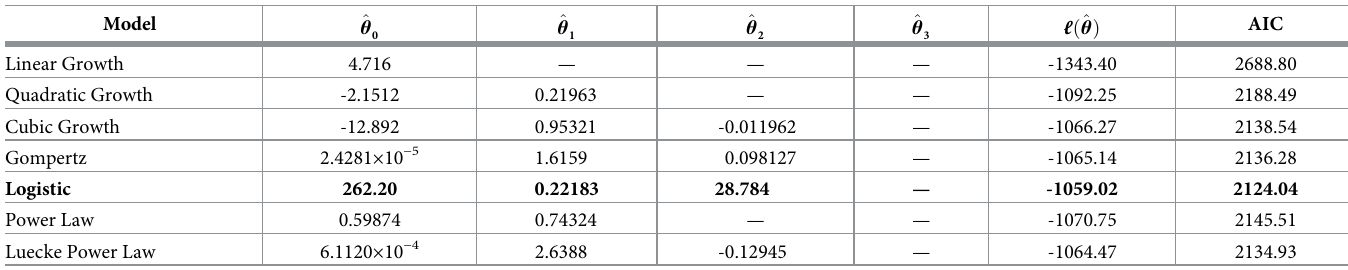
Table 27. Models for fetal blood flow to the placenta (mL/min vs. fetal mass in g for power law models, mL/min vs. gestational age in weeks for all other models). Model